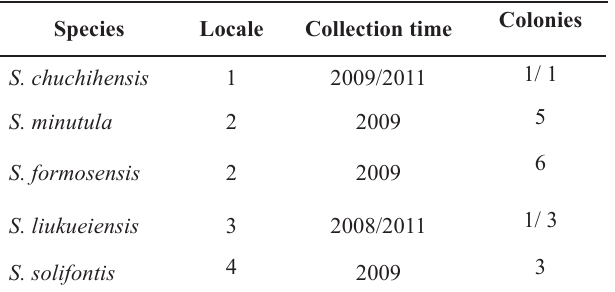
Table 1. Summary of the respective dates and locales of collections for the five Strumigenys species ( cf. Fig 1 for details of Taiwan geography).